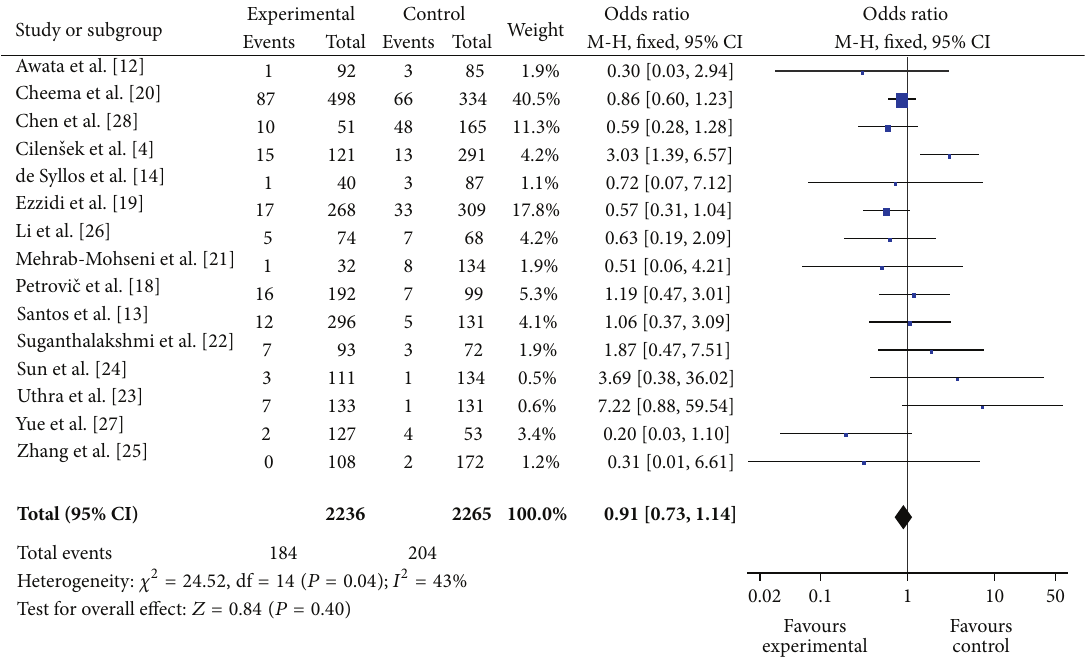
Figure 3: The forest plot of aa versus bb of eNOS polymorphism and overall DR risk.